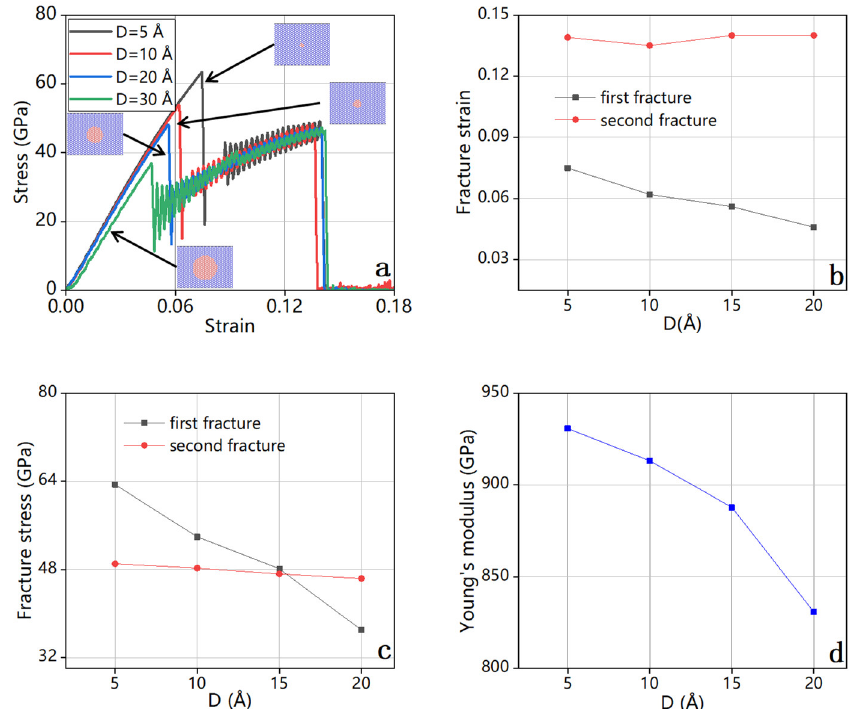
Figure 10. Mechanical properties of bilayer graphene with circular cracks of varying radii on a single layer: ( a ) stress–strain relationships, ( b ) fracture strain, ( c ) fracture stress, and ( d ) Young’s modulus. The stress–strain curves exhibit a distinctive double peak signal, which suggests a subsequent fracture of the two layers due to the presence of cracks on a single layer.